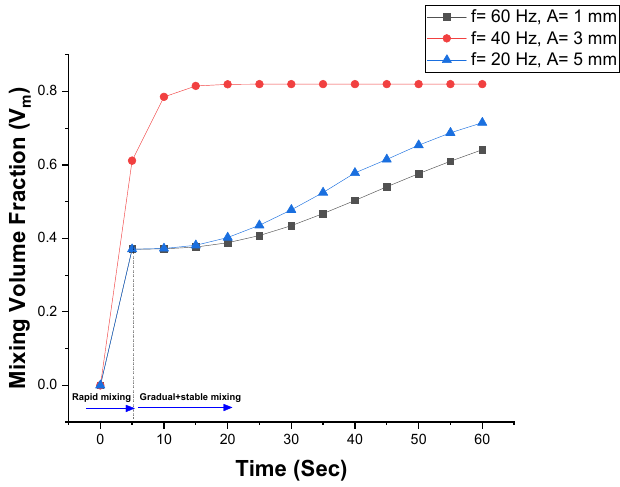
Figure 6. Plot of fractional mixing volume as a function of time.